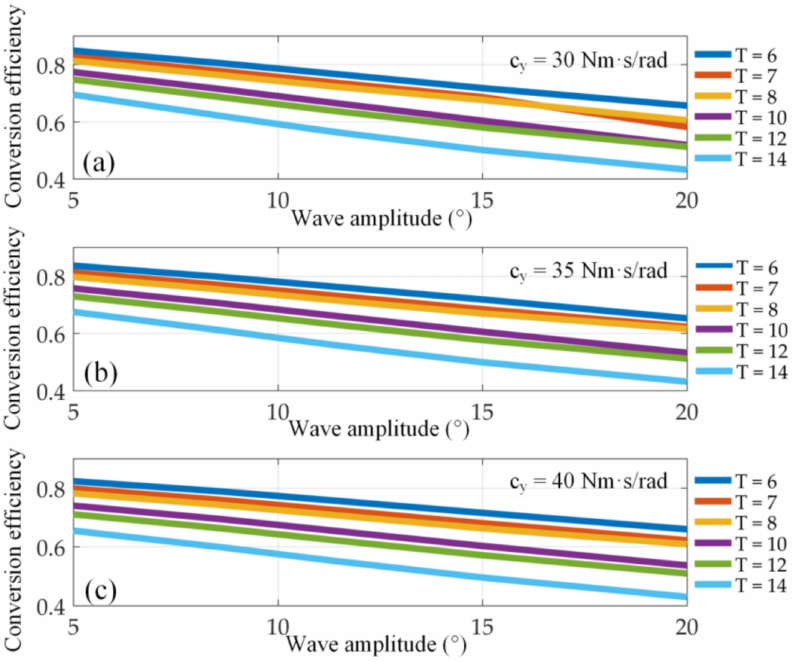
Figure 8. Influence of damping coefficient and pitch amplitude: ( a ) cy = 30; ( b ) cy = 35; ( c ) cy =